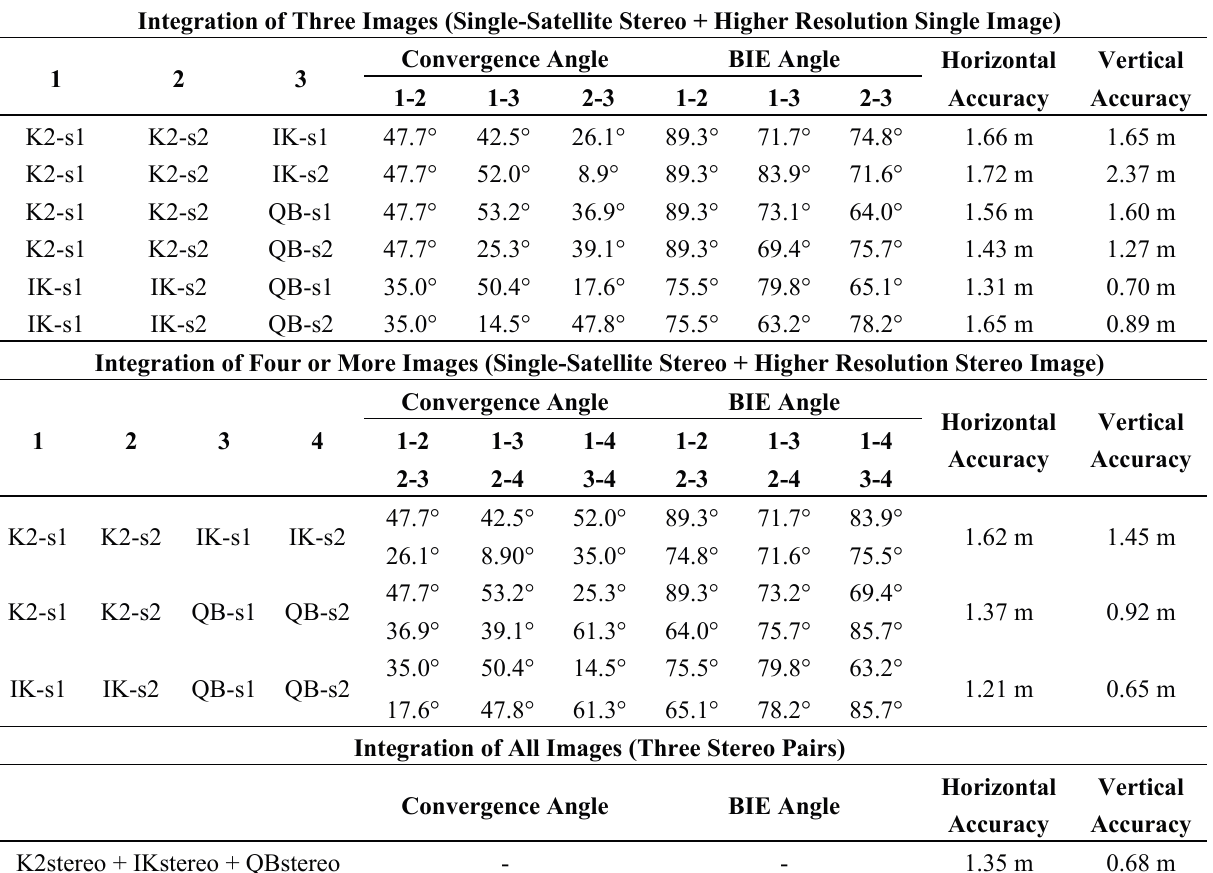
Table 4. Mapping accuracy of three or more satellite